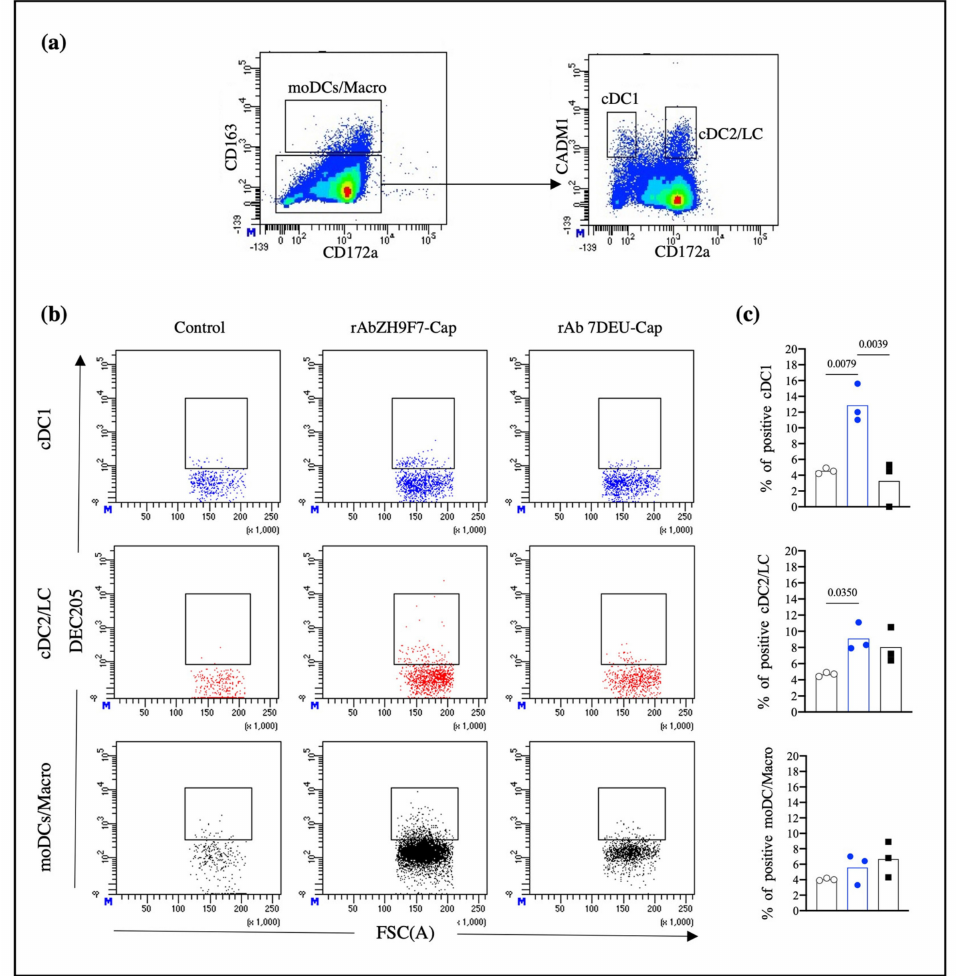
Figure 4. rAb ZH9F7-Cap targets skin cDC1 s and cDC2s/LCs in vivo. ( a ) Skin migratory CD163 − /low CD172a +/ − cells were selected and analyzed for CADM1 expression, obtaining skin cDC1 (CD163 − CADM1 + CD172a − /low ) and cDC2/LC (CD163 − /low CADM1 + CD172a high ) cells. ( b ) Skin cDC1, cDC2/LC, and moDCs/Macro positive for targeting in vivo. The dot plot represents results from one of three experimental units from the control, rAb ZH9F7-Cap, and rAb 7DEU-Cap. ( c ) Aver- age percentages of cDC1, cDC2/LC, and moDCs/Macro positive from in vivo targeting from three groups. PBS control (gray); rAb ZH9F7-Cap (blue); Isotype control rAb 7DEU-Cap (black). One-way ANOVA and the Tukey–Kramer test for multiple comparisons of means were performed ( p < 0.05). p -values denote statistically significant differences in the means of the different